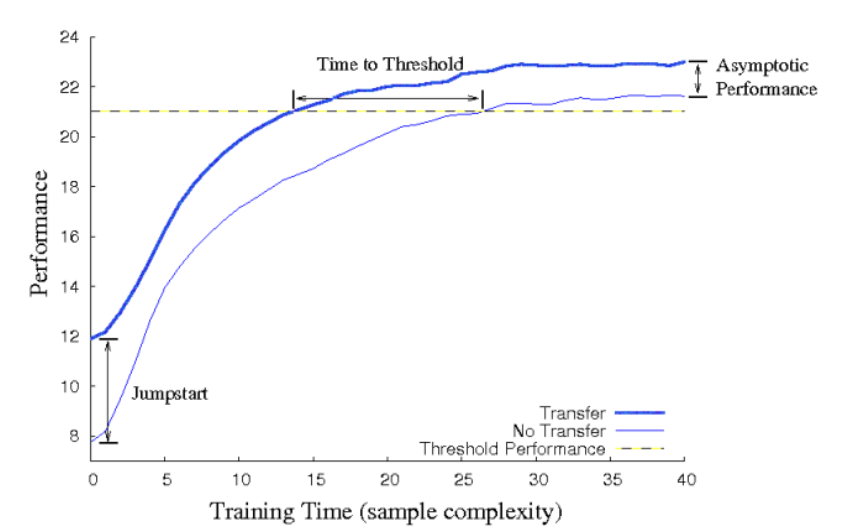
Figure 2. Different metrics for measuring TL